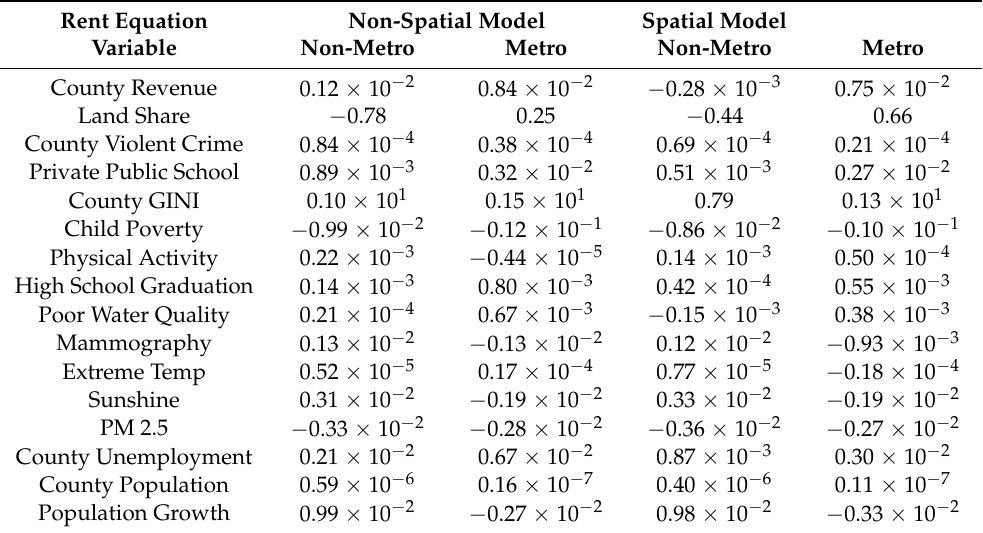
Table 4. Total marginal effects for wage equations in the continental United States: metro versus non-metro.